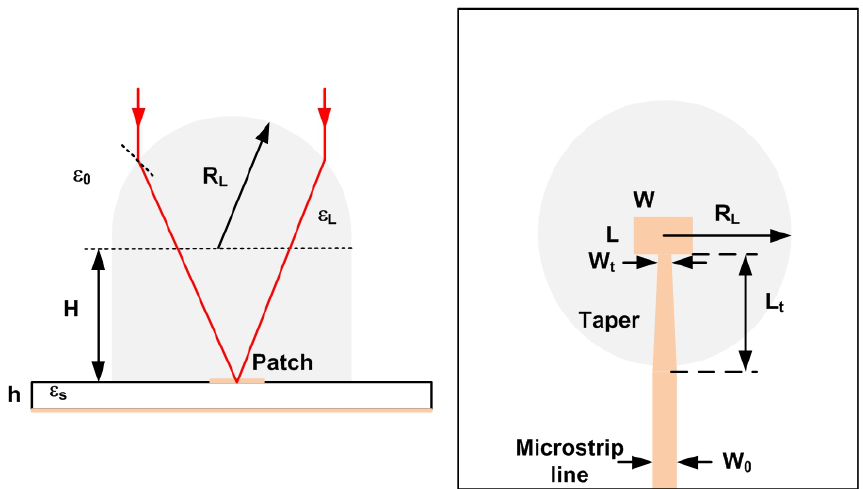
Figure 8. Geometry and dimensions of the